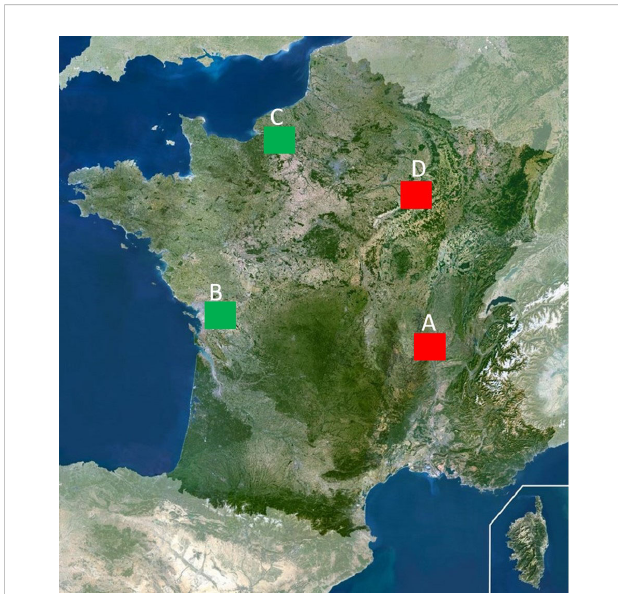
FIGURE 1 Location of the four study sites. (A) Etang du Grand Birieux, (B) Baie de l ’ Aiguillon, (C) Grand ’ Mare, (D) Lac du Der. The green squares indicate sites where prevalence was estimated (see text) and no botulism outbreak was detected. The red squares indicate sites where prevalence was estimated and botulism outbreaks were